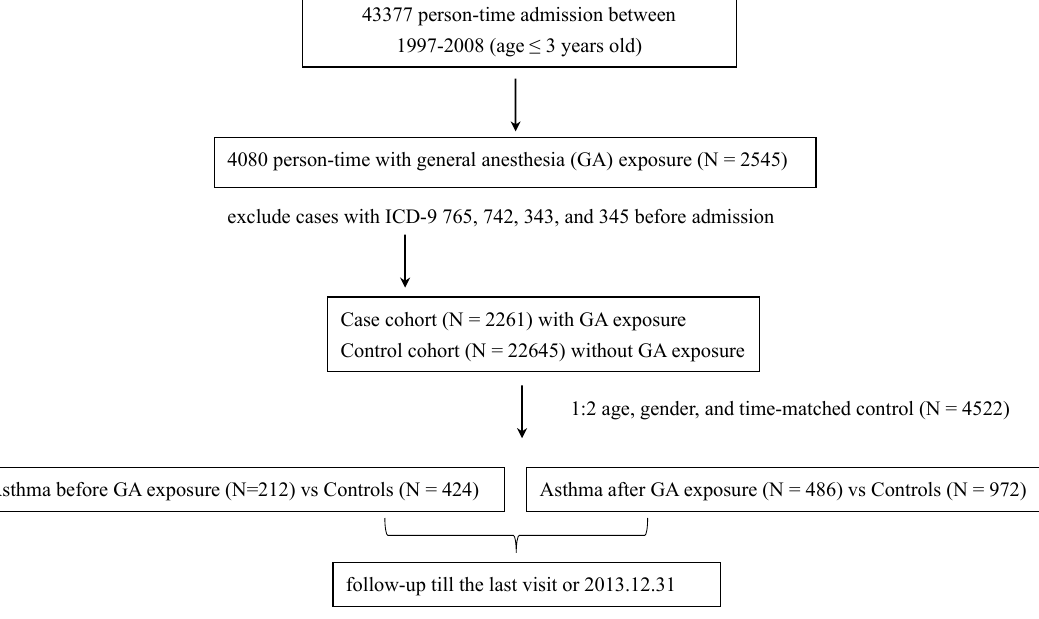
Figure 1. Algorithm for study design and patient selection. The study cohort included 43,377 children under the age of three years who were hospitalized from 1997 to 2008. Among them, 4080 person-times were exposed to GA. After exclusion cases using ICD-9 codes 765 (disorders related to short gestation and low birthweight), 742 (other congenital anomalies of the nervous system), 343 (infantile cerebral palsy), and 345 (epilepsy and recurrent seizures) before admission, we ultimately included 2261 subjects in the study cohort, while 4522 children (in a 1:2 ratio, matched by age, sex, and time) made up the control cohort. The observation period started on the index date and ended on the last clinical visit on December 31, 2013. The length of follow-up time was calculated for each patient’s last clinical visit. To avoid patients with overdiagnosis of asthma (ICD-9 493), the enrolled patients have had at least two outpatient visits (within 28 days) or one inpatient visit. In addition, we investigated asthma development and clinical visits after GA exposure.